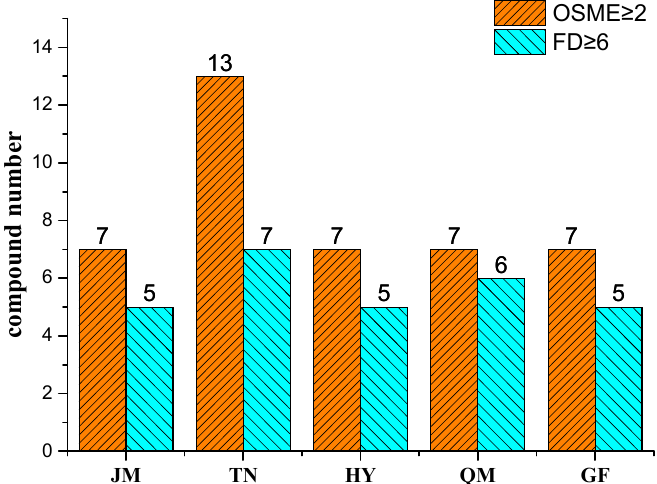
Figure 5. Identification of key aromatic compounds by frequency detection (FD) ≥ 6 and order-specific magnitude estimation (OSME) ≥ 2 in five mango pulps.